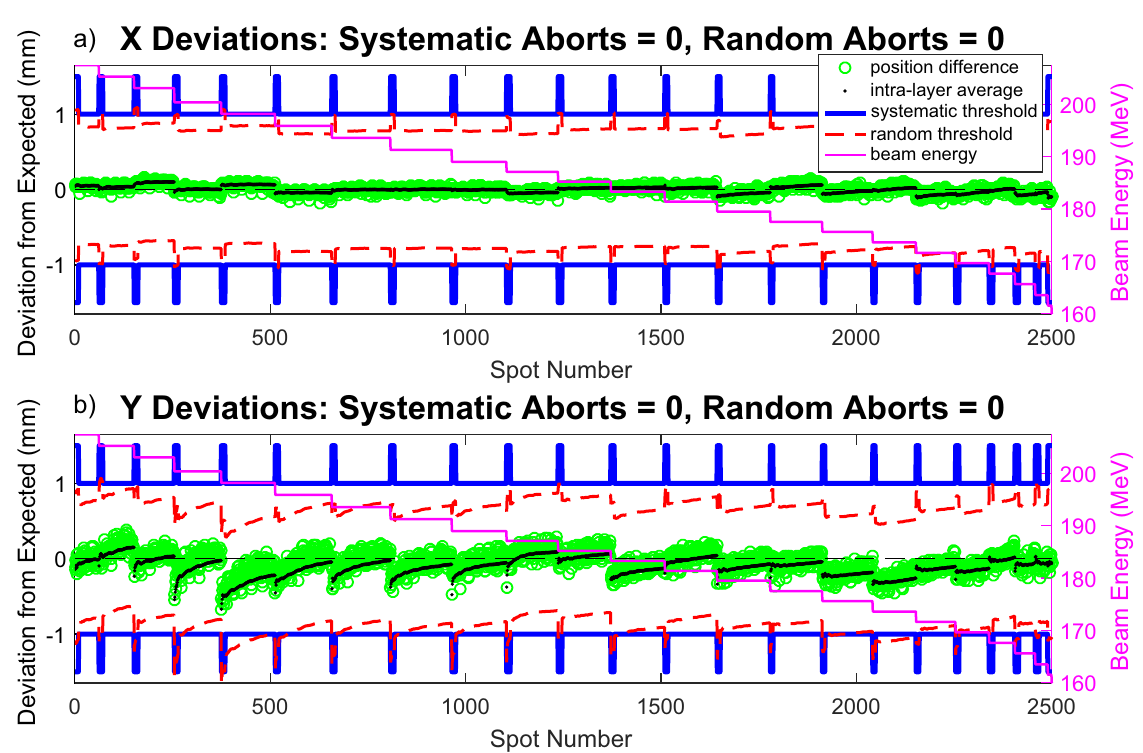
Fig 3. Spot position deviation analysis in the time domain. The random and systematic components of spot position deviations in both x (a) and y (b) are computed and compared to predefined action thresholds. The green circles represent the raw position deviation, while the black dots show the running average deviation in an energy spill. The tolerance for the systematic component of the error is given by the solid blue lines, which the running average deviation (black dots) should not cross. Analogously, the tolerance for the random component of the error is given by the dotted red lines (fixed expansion of the running systematic average), which the positional deviations (green circles) should not exceed.